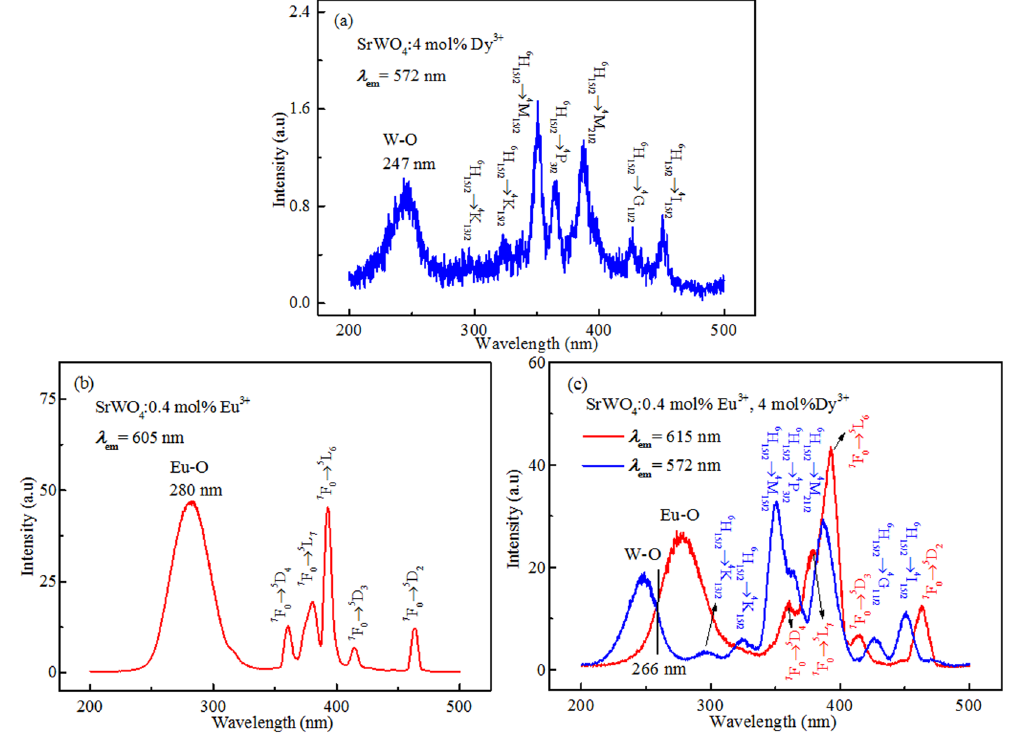
Figure 5. Excitation spectra of ( a ) SrWO 4 : 4 mol% Dy 3 + , ( b ) SrWO 4 : 0.4 mol% Eu 3 + , and ( c ) SrWO 4 : 0.4 mol% Eu 3 + , 4 mol% Dy 3 + phosphors at room